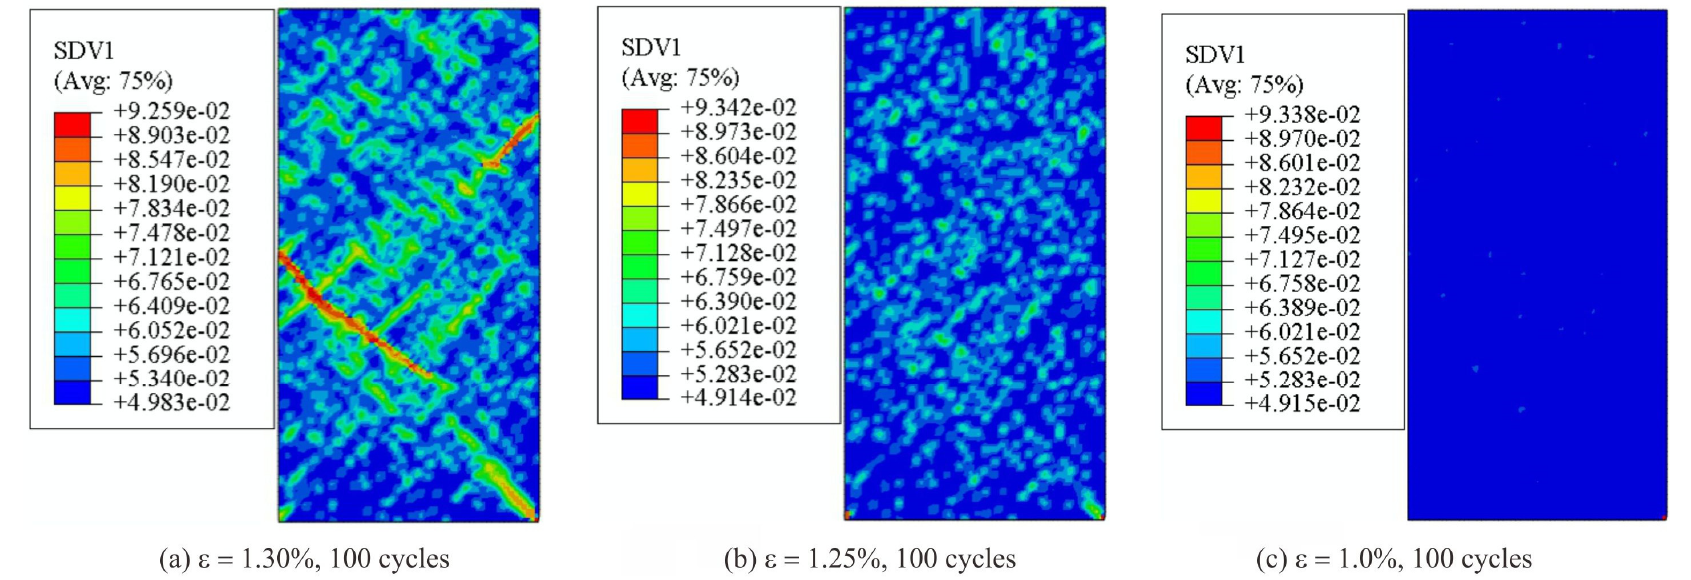
Figure 7. Shear band patterns for the samples after 100 cycles. ( a ) ε = 1.30%; ( b ) ε = 1.25%; ( c ) ε = 1.0%.